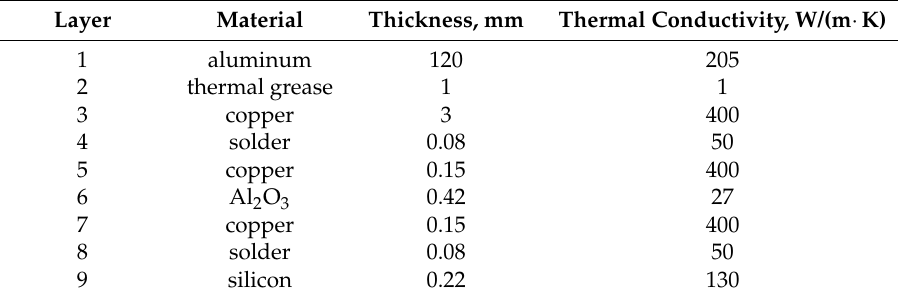
Figure 4. Cross ‐ section of the model.